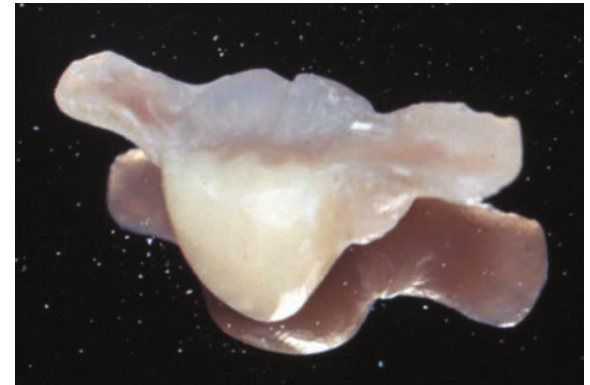
Figure 1- Cast obtained after cavity preparation, with conservative and expulsive shape, restricted to enamel thickness